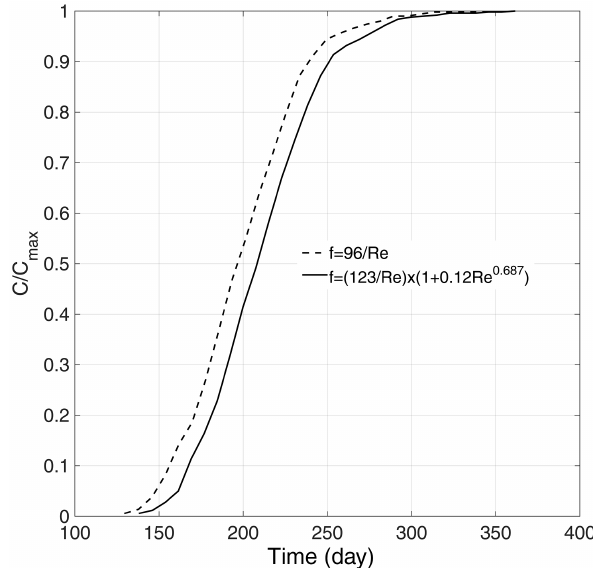
Figure 13. Breakthrough curves of hypothetical continuous con- tamination released in correspondence to the hotspot, determined for linear and nonlinear flow models, evaluated at the downstream boundary.